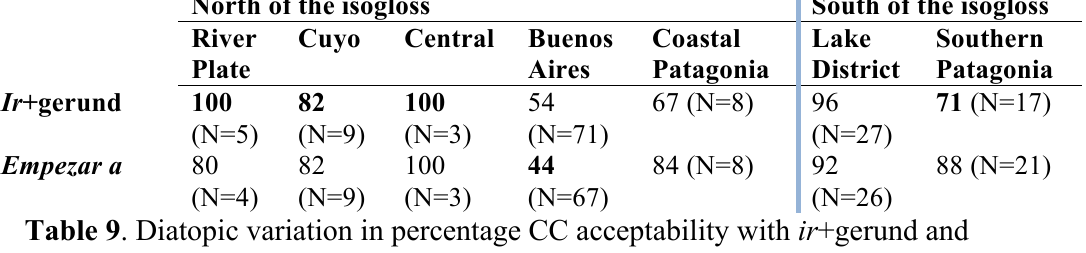
Table 9 . Diatopic variation in percentage CC acceptability with ir +gerund and empezar a